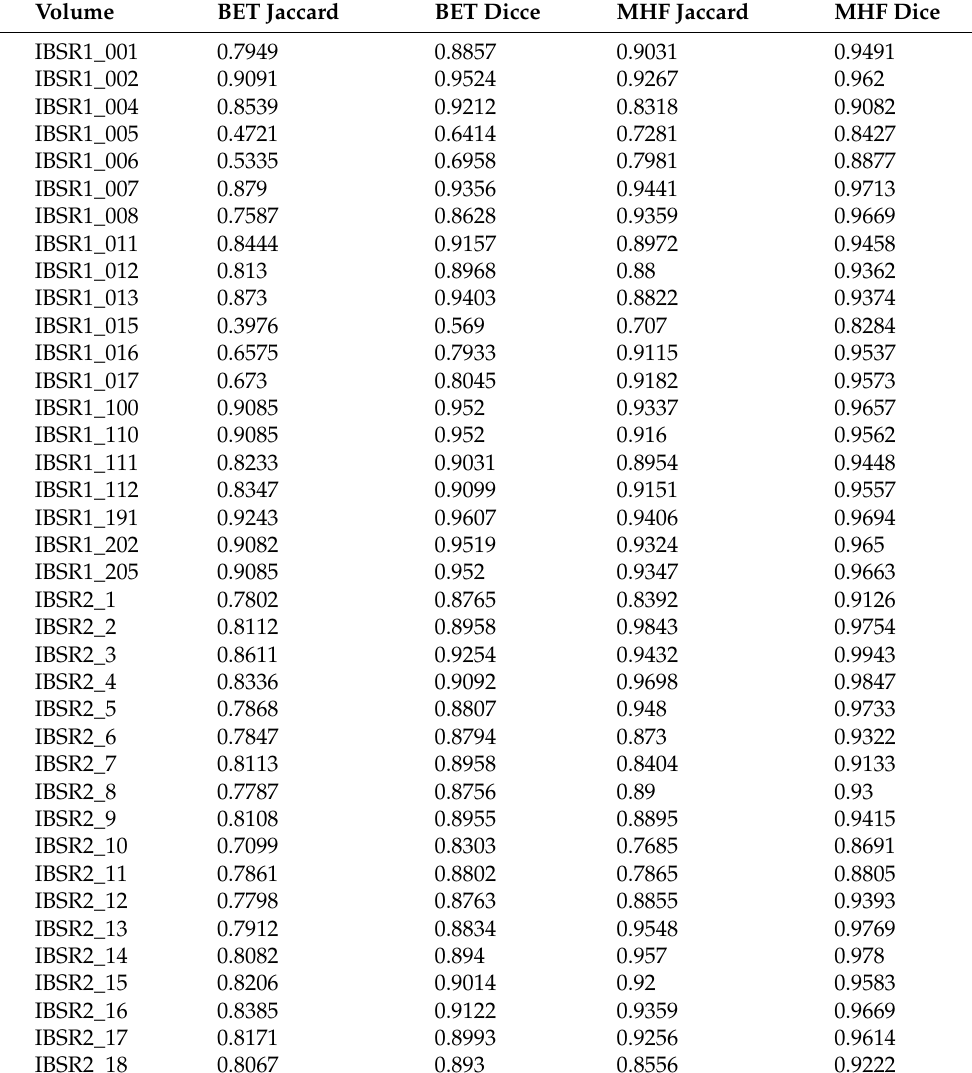
Table 1. Jaccard and Dice indices computed for 38 volumes of an MRI obtained from the IBSR repository. The brain segmentation in this work utilizes the steps provided in Figure 8, and the computed indices are in columns MHF Jaccard and MHF